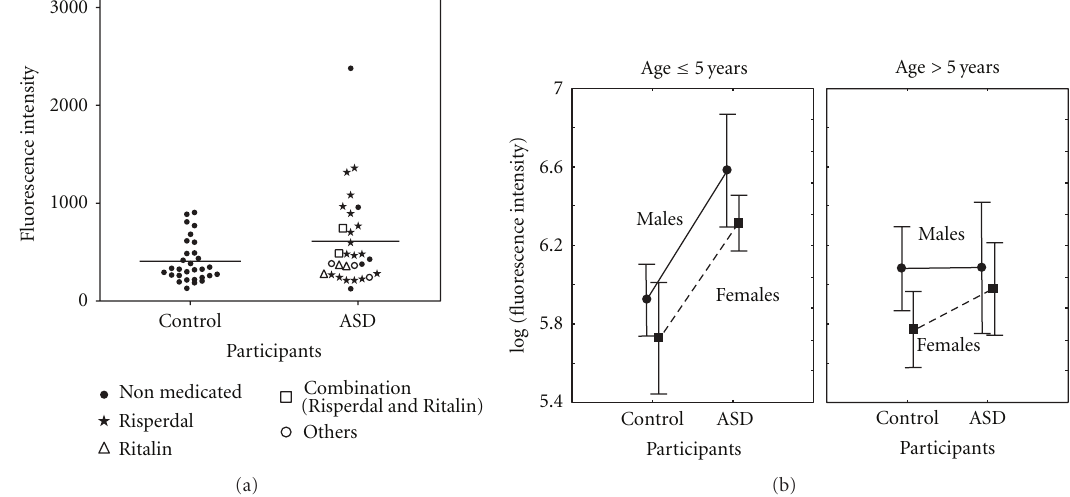
Figure 2: (a) Complement factor I activity in EDTA plasma from children with ASD ( n = 30) and healthy control children ( n = 30). A scatter plot of factor I activity for each individual is shown. Samples from ASD children who were not under medication at the time of the investigation, those under medication with Risperdal, Ritalin, a combination thereof, or other medications such as antipsychotics (thiorida- zine) or anticonvulsants (fenobarbital and sodium valproate) are shown. (b) Mean values and standard errors of the complement factor I activity in EDTA plasma are shown for the di ff erent age groups and genders for both children with ASD and the healthy control group. In the ASD group; age ≤ 5 years: males ( n = 17), females ( n = 4) and age > 5 years: males ( n = 6), females ( n = 3). In the healthy control group; age ≤ 5 years: males ( n = 4), females ( n = 10) and age > 5 years: males ( n = 9), females ( n =